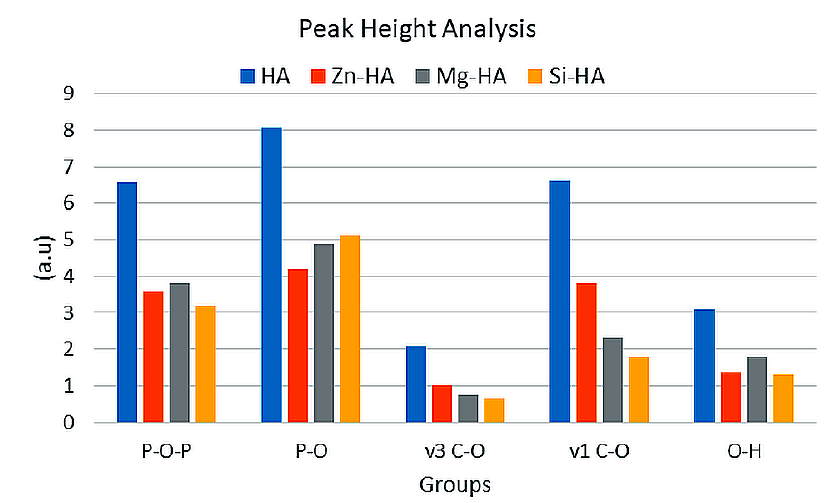
Figure 2. Peak height analysis showing a change in peak/band intensities after substitution of HA with Zn, Mg and Si. Change in peak intensity exhibits the influence of substituted ions on the HA structure. The significant change in peak intensity observes at O–P–O (604–564 cm − 1 ), P–O (1100–960 cm − 1 ),